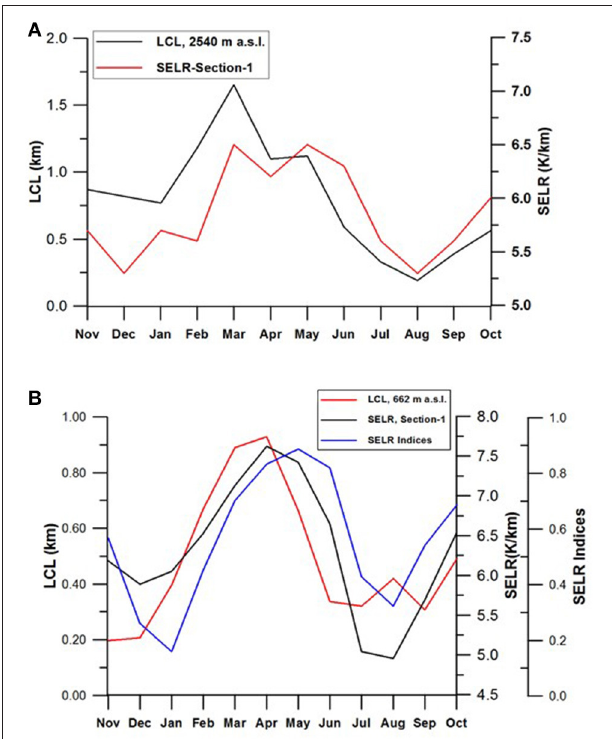
FIGURE 10 | Seasonal variations of valley scale SELR is closely linked to the LCL variations in the monsoon region. Both (A) Upper Ganga basin and (B) Sutlej/Beas basin show similar response suggesting it as a regional characteristic influencing the valley scale SELR. Derived regional SELR indices are closely linked to the seasonal variations in LCL confirming this